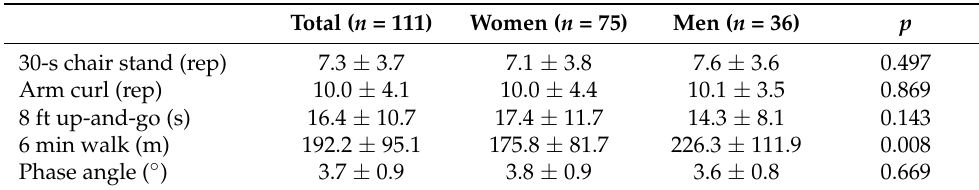
Table 2. Physical fitness and phase angle of the participants.